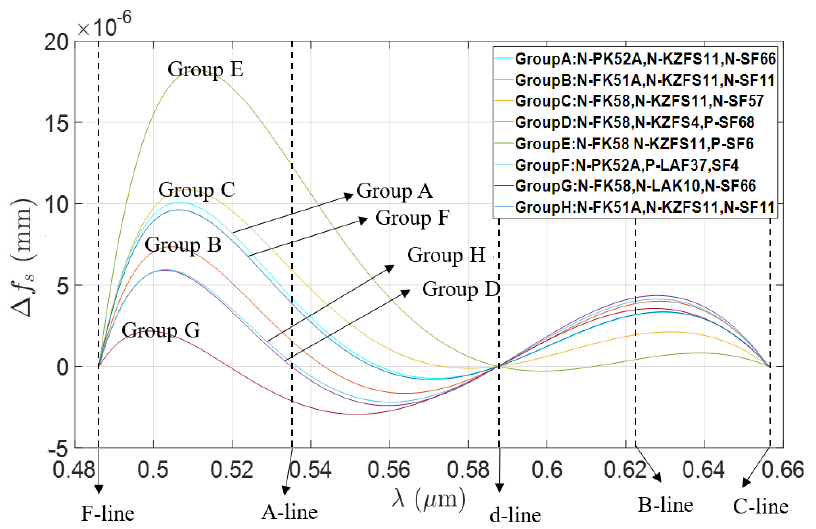
Figure 7. Real longitudinal chromatic aberration curve optimized for the eight triplet lens groups selected by the illustration method.